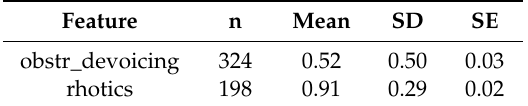
Table 11. Mean Accuracy with respect to Feature for L2 English.